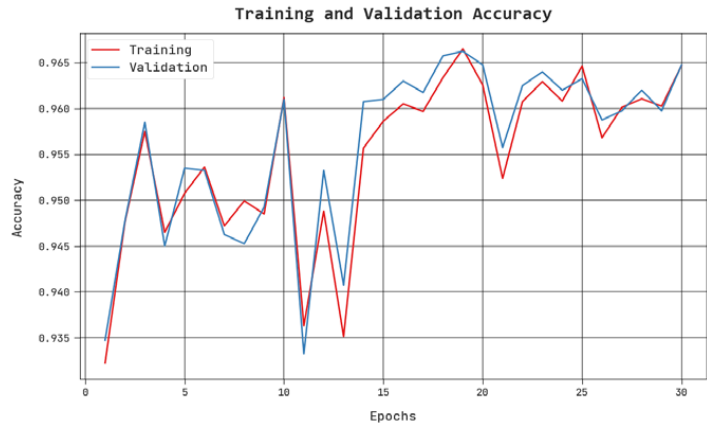
Figure 8. TACC and VACC analysis of PPIE-ODLASC approach.